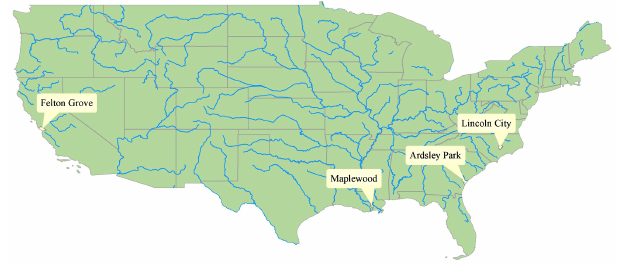
Fig. 1 . Four coastal case study sites in the United